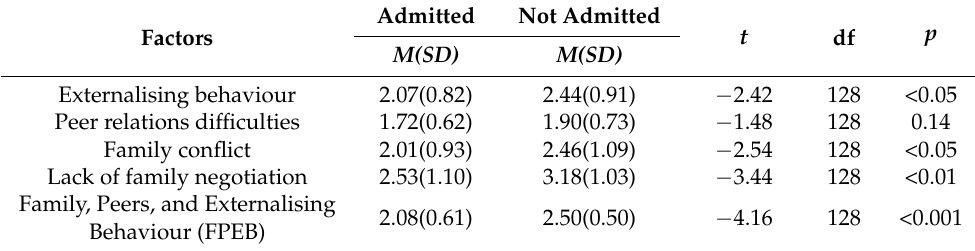
Table 3. T -tests exploring the differences between students who were admitted to the following academic year and those who were not on the Family, Peers, and Externalising Behaviour (FPEB) factors and total score.